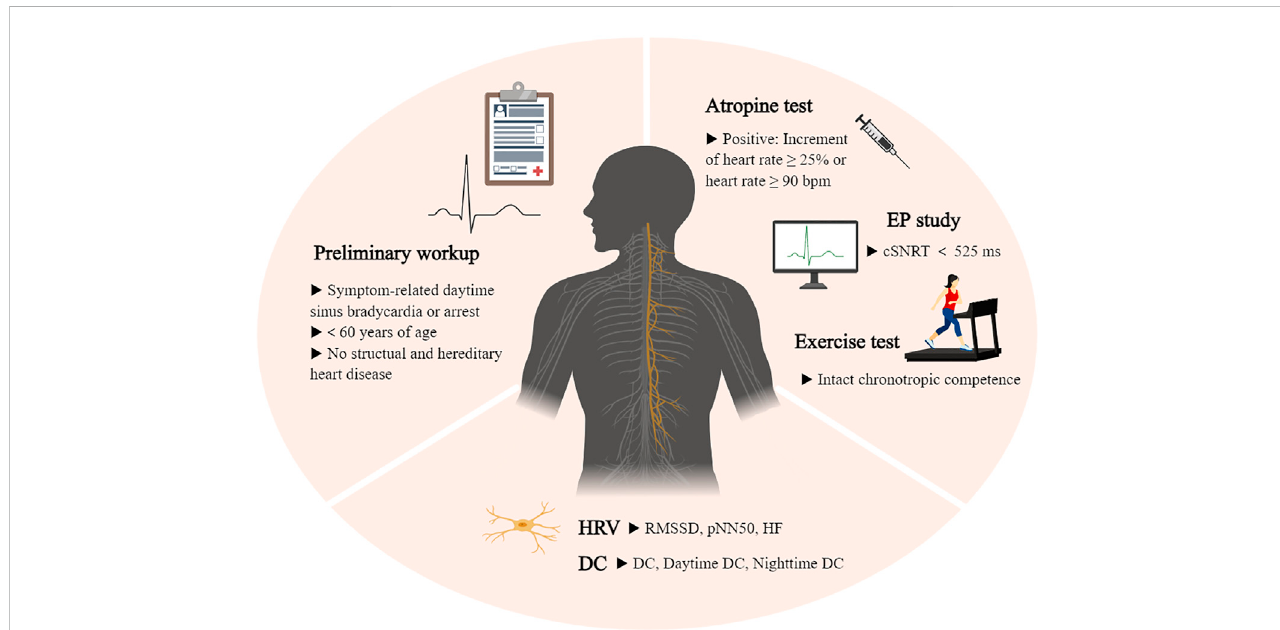
FIGURE 3 Illustration of the criteria process. Selection criteria for patients with sinus node dysfunction undergoing cardioneuroablation. cSNRT, sinus node recovery time; DC, deceleration capacity; EP study, electrophysiological study; HF, high frequency; HRV, heart rate variability; pNN50, percentage of successive N-N interval differences over 50 ms; RMSSD, successive cardiac cycle difference value mean square root.